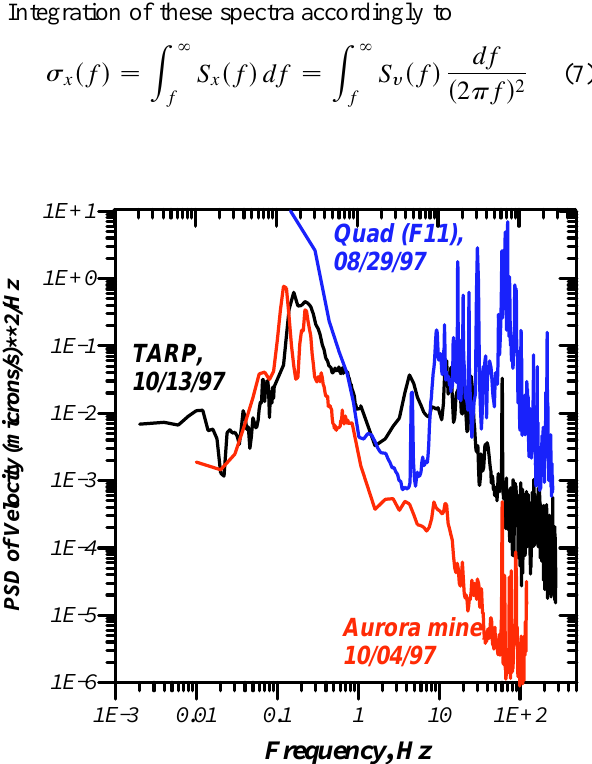
FIG. 12. Earthquake waves. Record starts at 7:45 p.m. October 14, 1997.